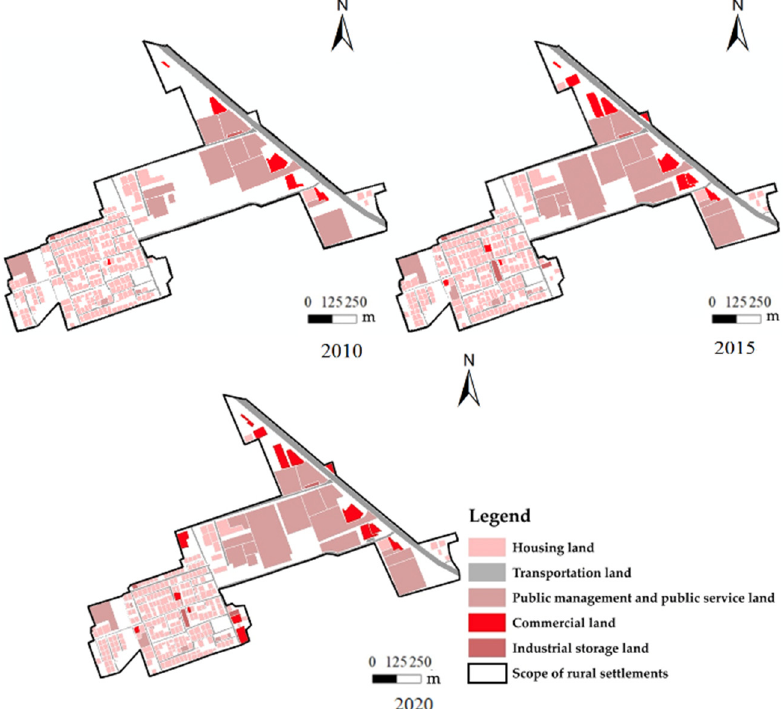
Figure 3. The evolution of rural residential land in Tian Village from 2010 to 2020.